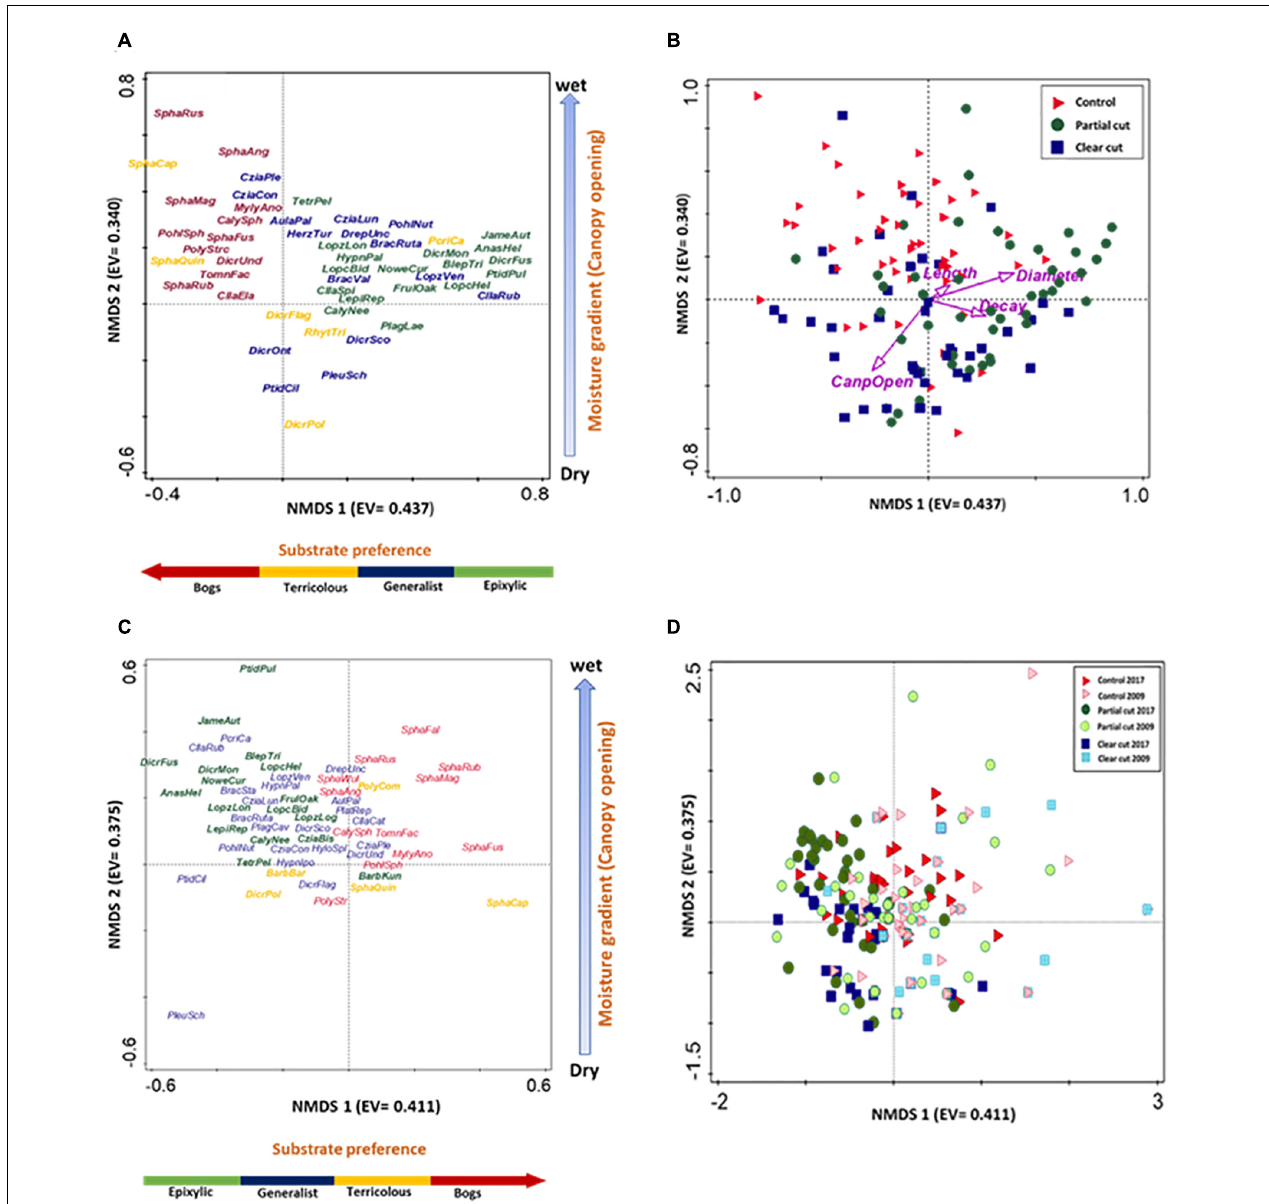
FIGURE 3 | NMDS ordinations of species assemblages on coarse woody debris, with eigenvalues (EV) in brackets. (A,C) Species plots, (A) n = 59 species and (C) n = 84 species, stress values 0.161 and 0.138, respectively. Text colors indicate different substrate types: epixylic (green), bog (red), generalist (blue) and terricolous species (yellow). Some species close to the 0,0 position were deleted to improve clarity of the graph. (B,D) CWD spread based on harvest treatment type, (B) n = 150, and (D) n = 262, stress value of 0.161. (B) Symbol colors indicate: control (blue square), partial cut (green diamond) and clear cut (black circle). Arrows indicate strength of habitat variable relationships with axes and direction of maximum change. (D) Symbols indicate: control 2009 (red right triangle), control 2017 (purple right triangle), partial cut 2009 (yellow circle), partial cut 2017 (blue circle), clear cut 2009 (blue square) and clear cut 2017 (green square).